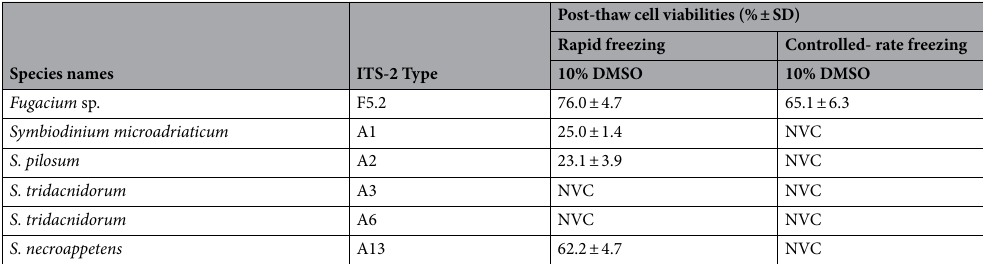
Table 3. Cell viabilities after the rapid freezing and controlled-rate freezing techniques using 10% dimethyl sulfoxide (DMSO) as the cryoprotectant agent (CPA). Values are mean percentage of three replicates (n = 3) ± standard deviation (SD) of the mean. NVC No viable cells observed.